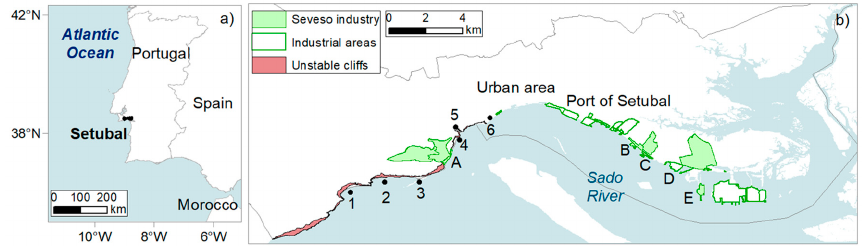
Figure 1. Coastline land use of the studied area: ( a ) Location of Setubal municipality; ( b ) Main exposed areas, with the location of the urban area and the Port of Setubal at the centre. 1—Portinho da Arr á bida